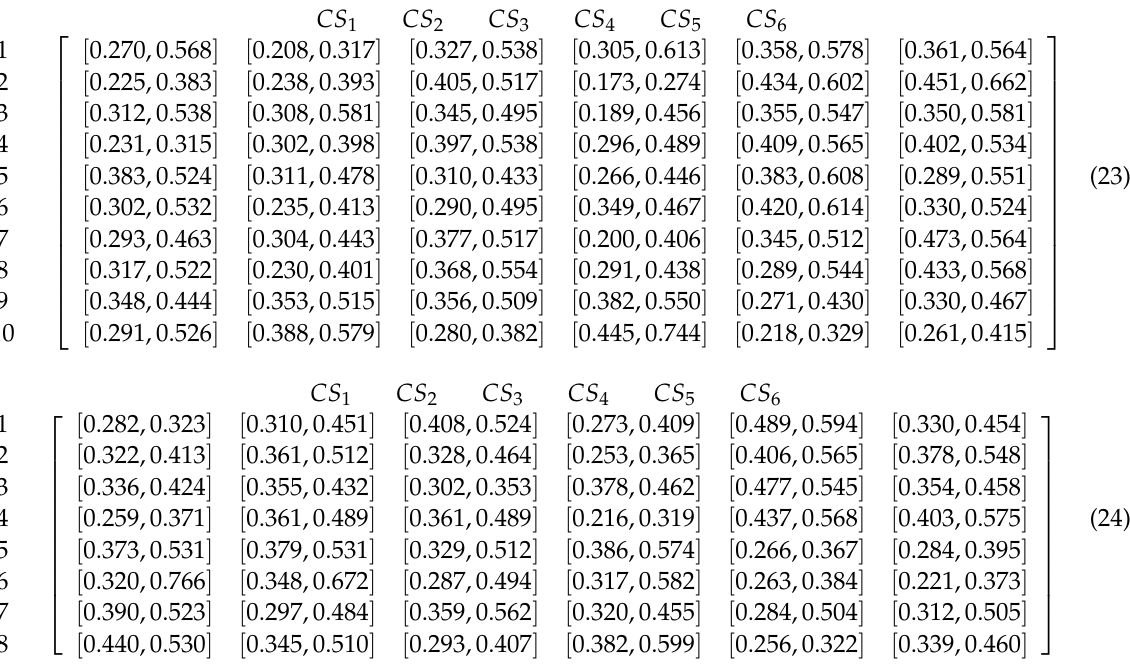
Step 4. Based on the normalized rough value matrices (Equations (23) and (24)), Equations (10)–(12) were used to compute the objective weights of the CV and economic criteria, with λ = 0.5. The results are presented in Table